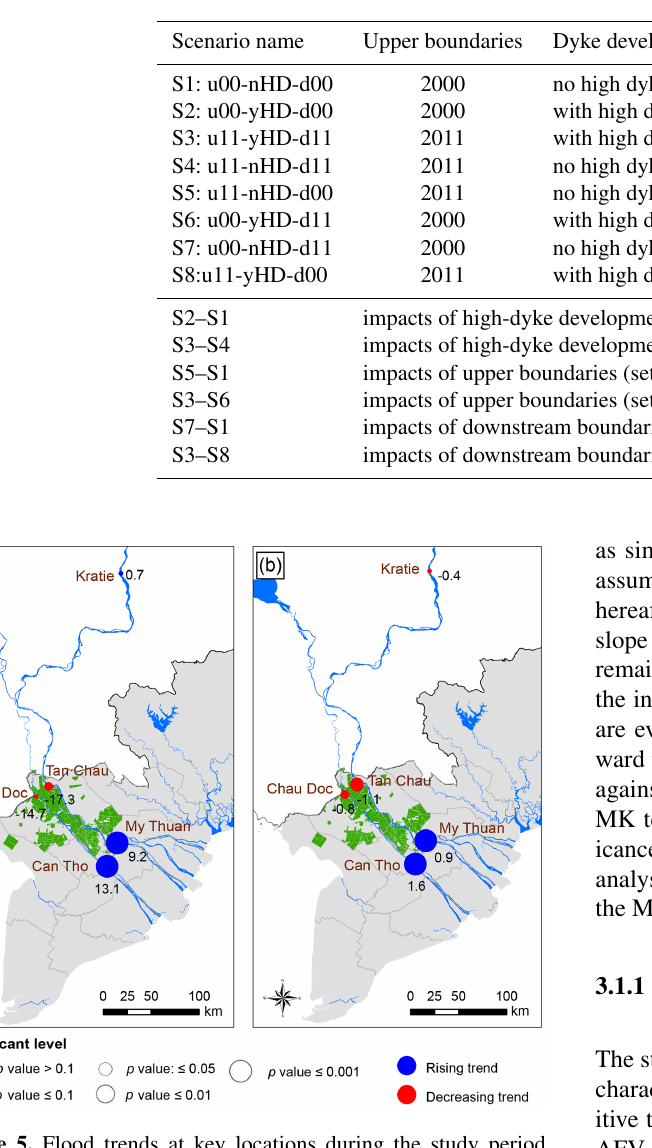
Table 3. Scenarios used to separate the impacts of high-dyke development, and changes in upstream and lower boundary conditions to the alteration of inundation dynamics in the VMD. Scenarios 1 and 3 are the baseline scenarios.